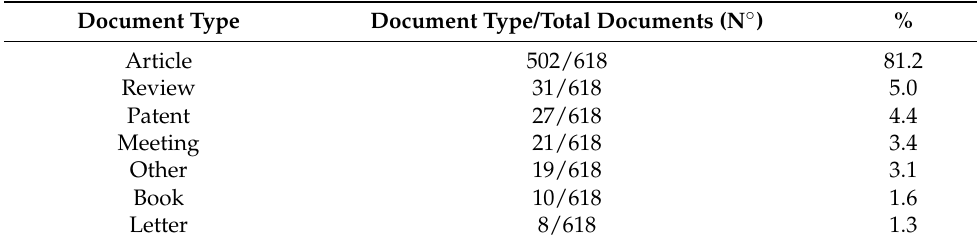
Table 2. Distribution of publications by document